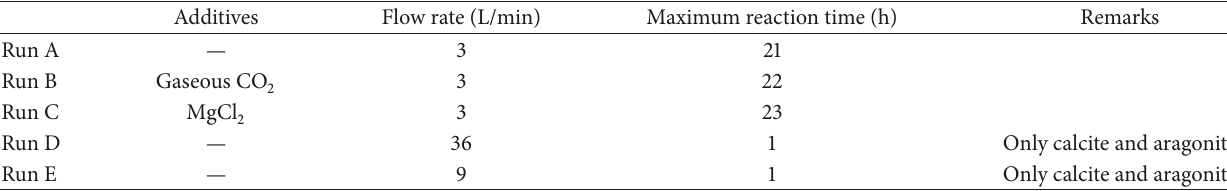
Table 1: Experimental